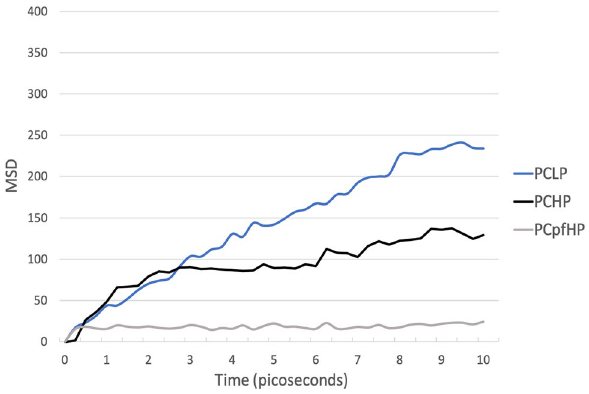
Fig. 18 Diffusion of Mg 2+ ions through low-pressure Portland cement (PCLP) in blue, high-pressure Portland cement (PCHP) in black, and Portland cement with particle hybrid glass and carbon fiber FCP material (PCpfHP) in